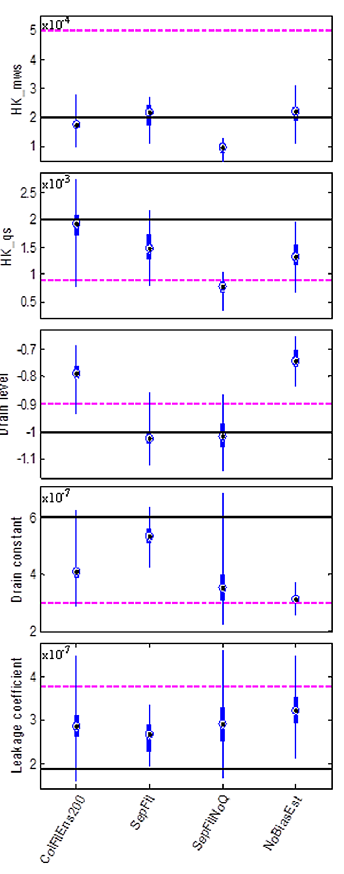
Figure 5. Spread of estimated parameters at the final update (syn- thetic test). Thin blue lines show the total spread of the ensemble and thick blue lines show the 25th and 75th percentile. Dots show the mean of the ensemble. The horizontal lines show the true pa- rameter value (black line) and the base parameter value (magenta line).